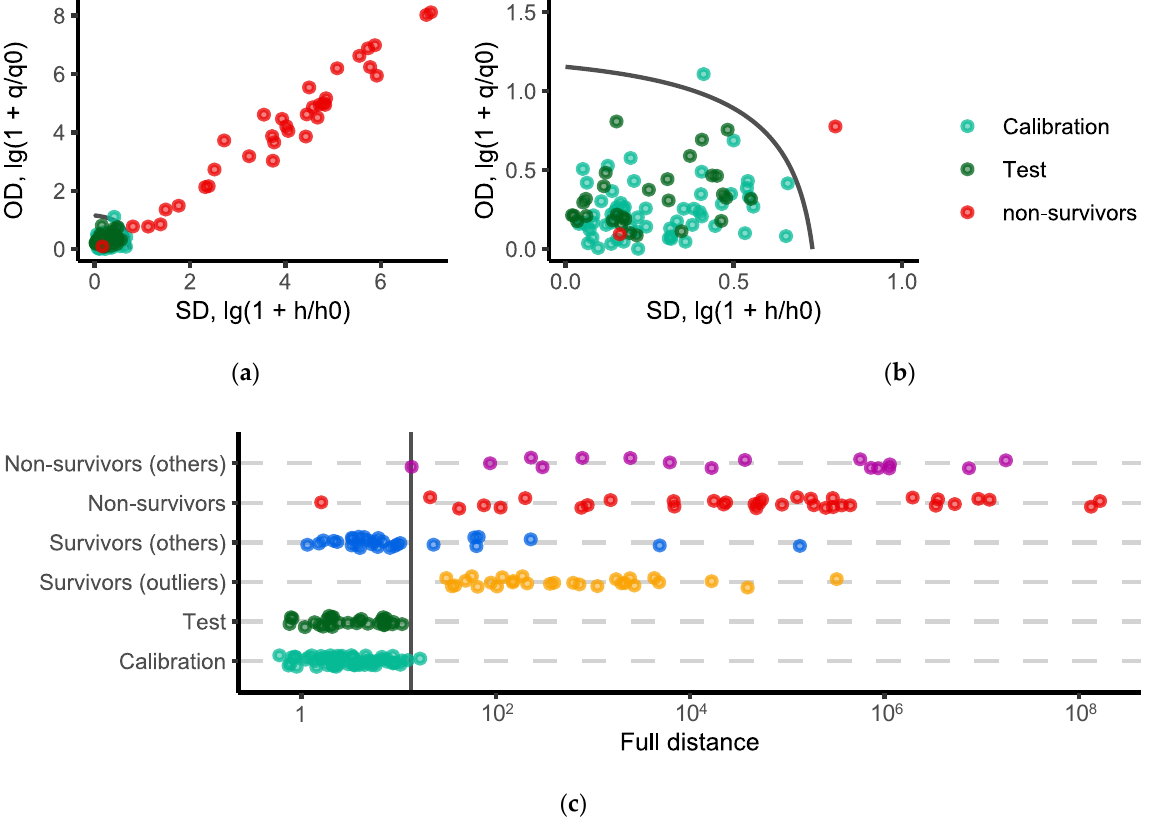
Figure 1. Distance plot ( a ) in original and ( b ) zoomed scale; and ( c ) one-dimensional visualization of the results obtained with SIMCA (points are scattered along the y-axis to improve perception in the case of overlapping). The black solid line is the decision rule ( α =